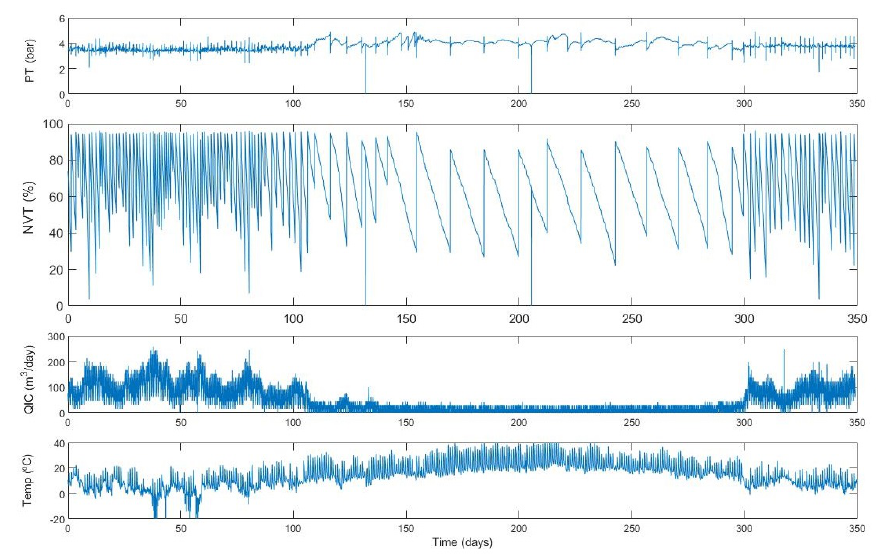
Figure 3. Pressure (PT) and level (NVT) in satellite-plant tank, NG consumption (QIC), and ambient temperature ( ◦